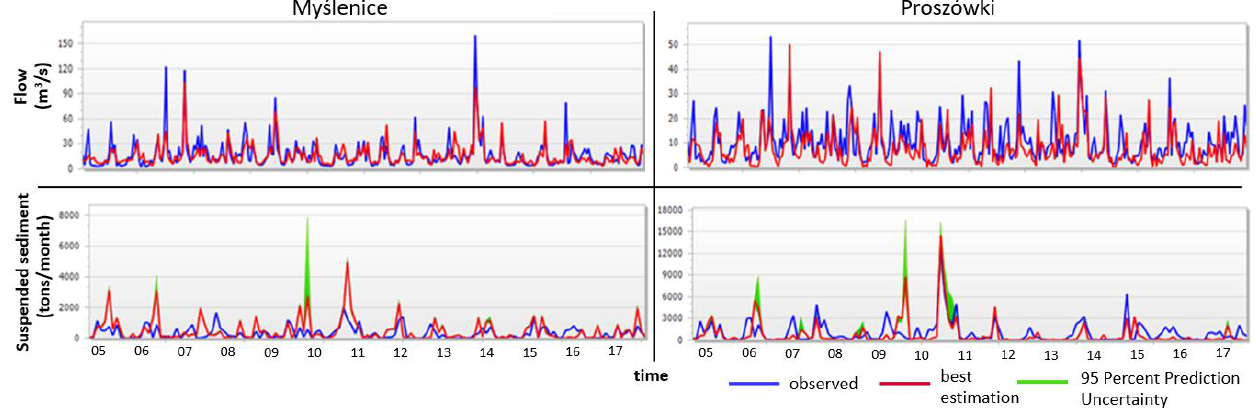
Figure 3. Comparison of the simulation to the observed results for the calculation profile of Myślenice and Proszówki for flow and suspended sediment.